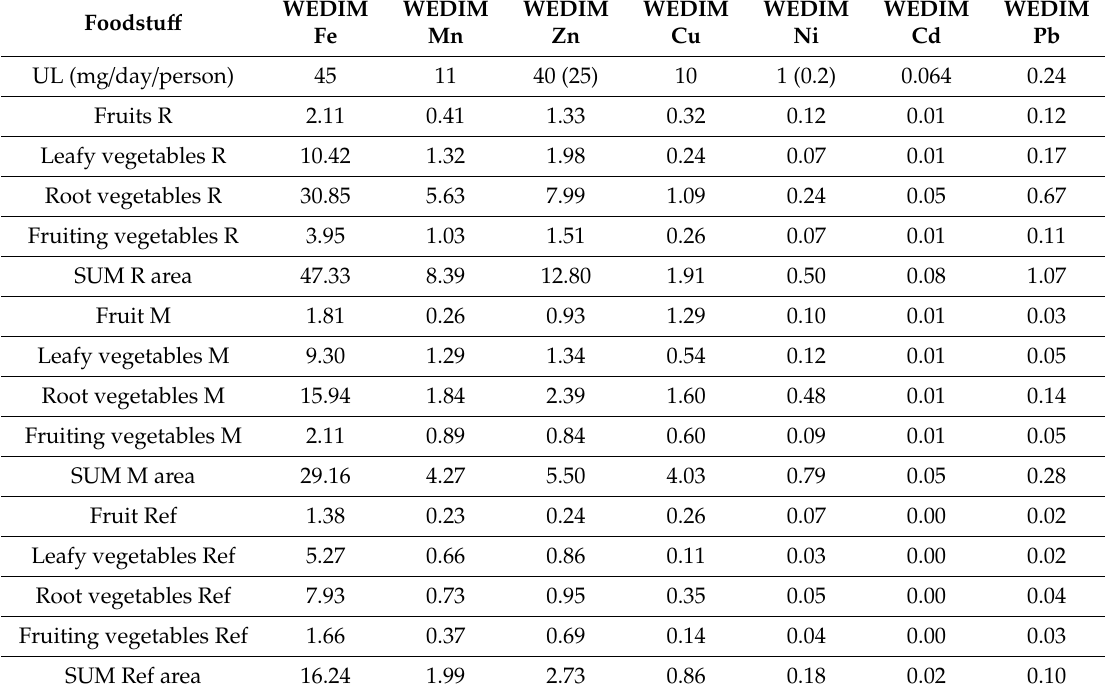
Table 6. The measured values for weighted estimated daily intakes (WEDIM) per all metals, sum of individual WEDIMs for each group of foodstu ff s and each area (mg / day / person) and the upper acceptable limit (UL), as compiled from the specialty literature